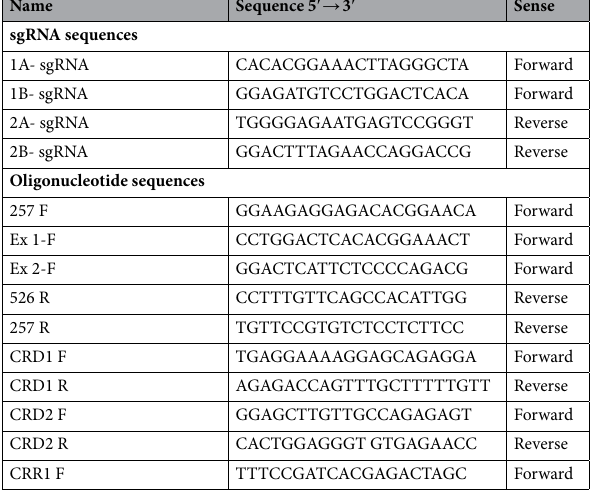
Table 1. sgRNA sequences used for gene editing. Oligonucleotide sequences used in RT-PCR, RT-qPCR and gDNA